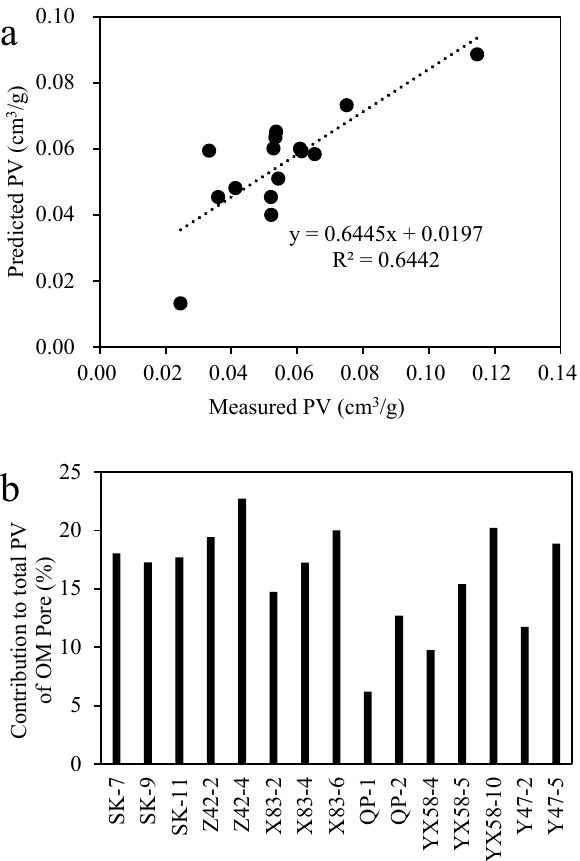
Figure 9. ( a ) Correlation between predicted pore volume and measured pore volume; ( b ) Contribution of OM pore to the total pore volume.